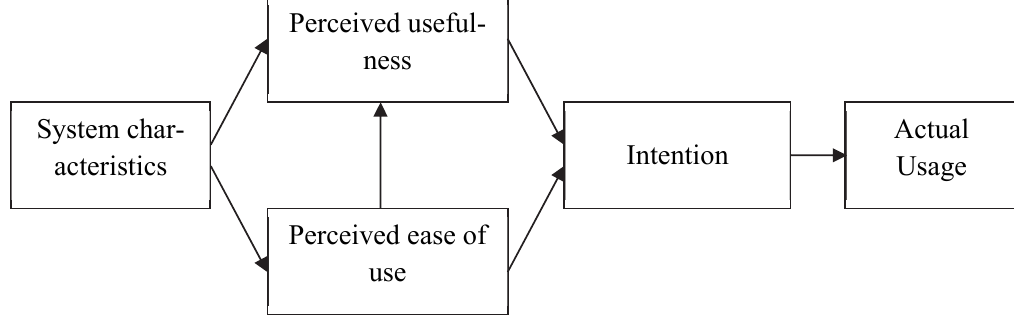
Fig. 1. Technology Acceptance Model